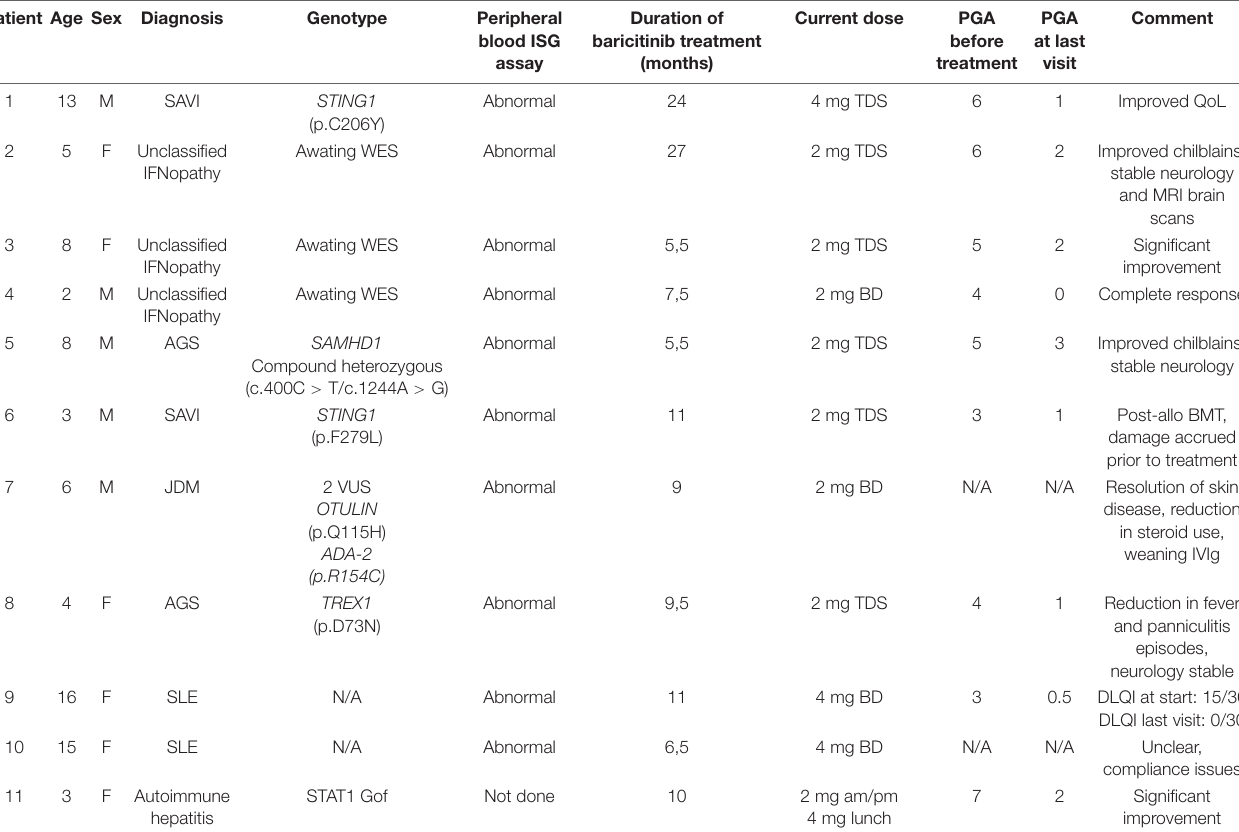
TABLE 2 | Summarised features of our cohort with monogenic and autoimmune interferonopathies treated with selective JAK 1/2 inhibitor baricitinib. Patient Age Sex